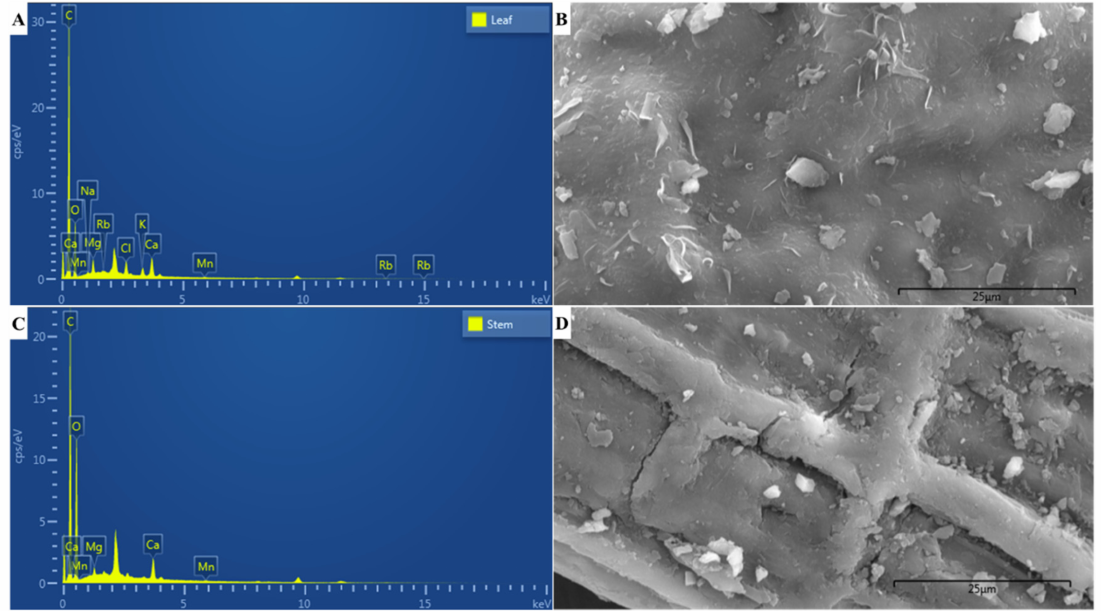
Figure 2. Elemental composition of powdered leaf and stem samples of Combretum molle . ( A ) EDX spectrum of powdered leaf; ( B ) SEM micrograph of powdered leaf particles used for EDX microanal- yses; ( C ) EDX spectrum of powdered stem; ( D ) SEM micrograph of powdered stem particles used for EDX